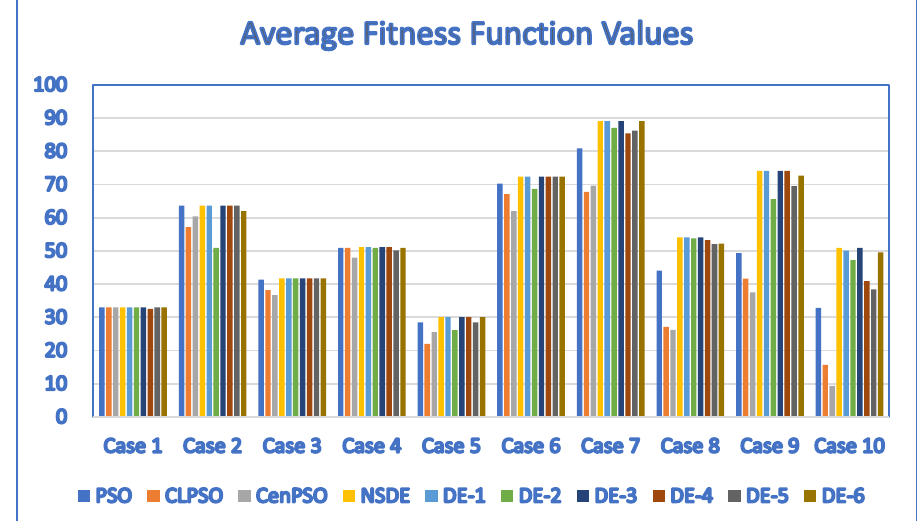
Figure 4. Average fitness function values for r D = r P = 0.1 when NP = 30.